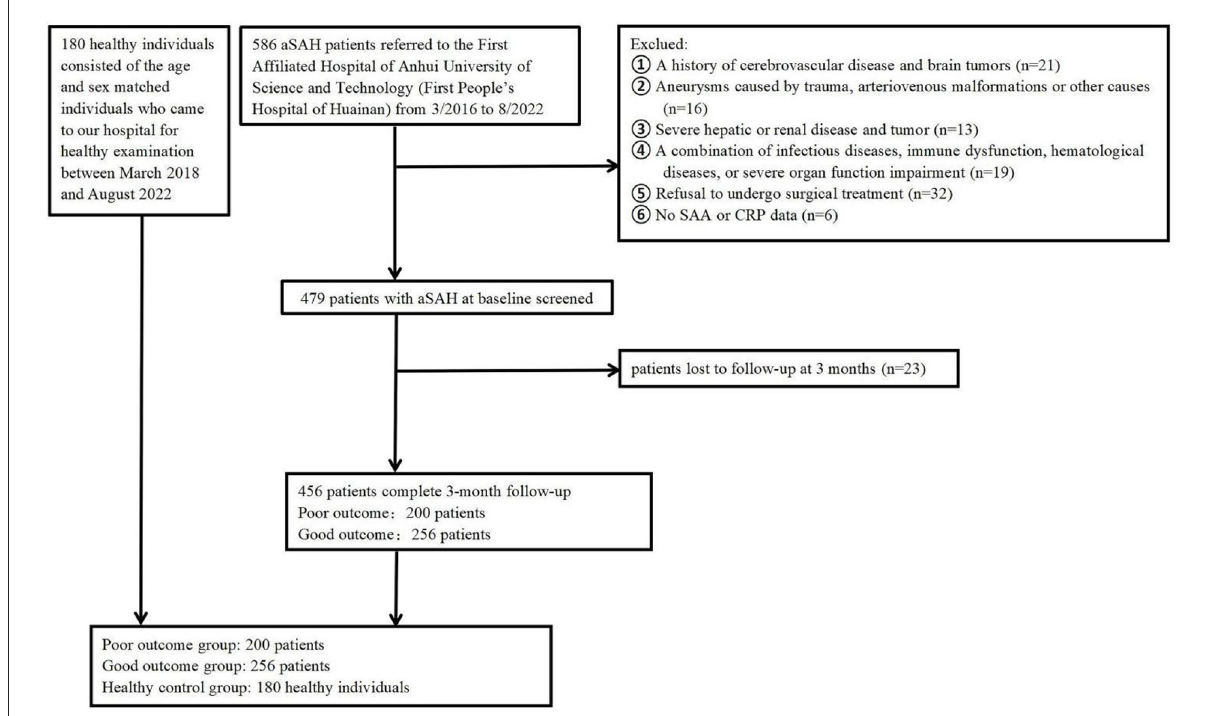
FIGURE1 Flowchart of participant selection. aSAH, Aneurysmal subarachnoid hemorrhage; SAA, serum amyloid A; CRP, C-reactive